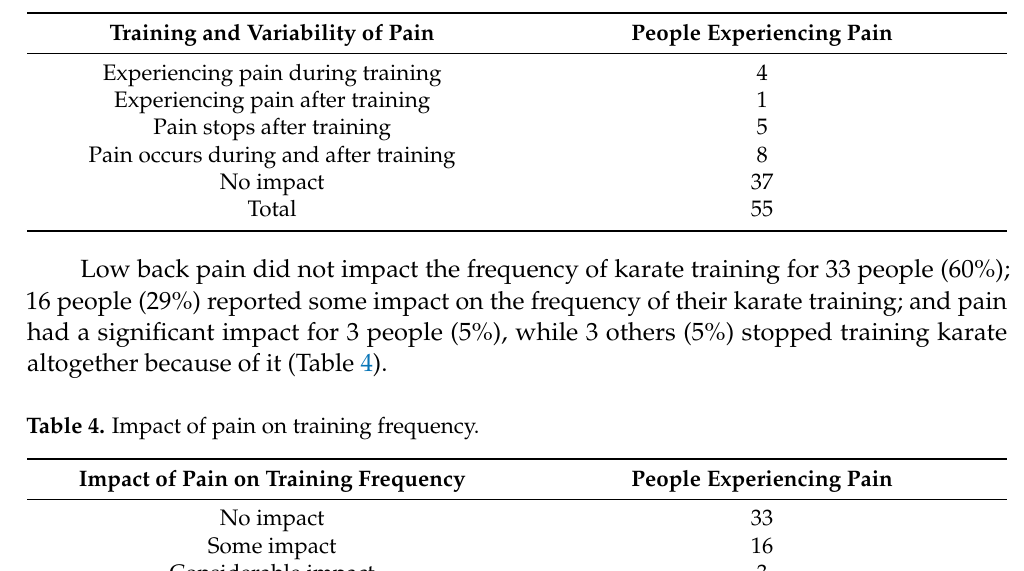
Table 3. Impact of karate training on low back pain.